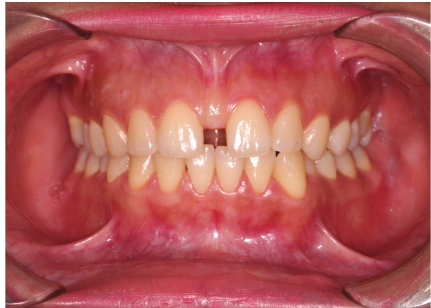
Figure 1: Maxillary midline diastema.